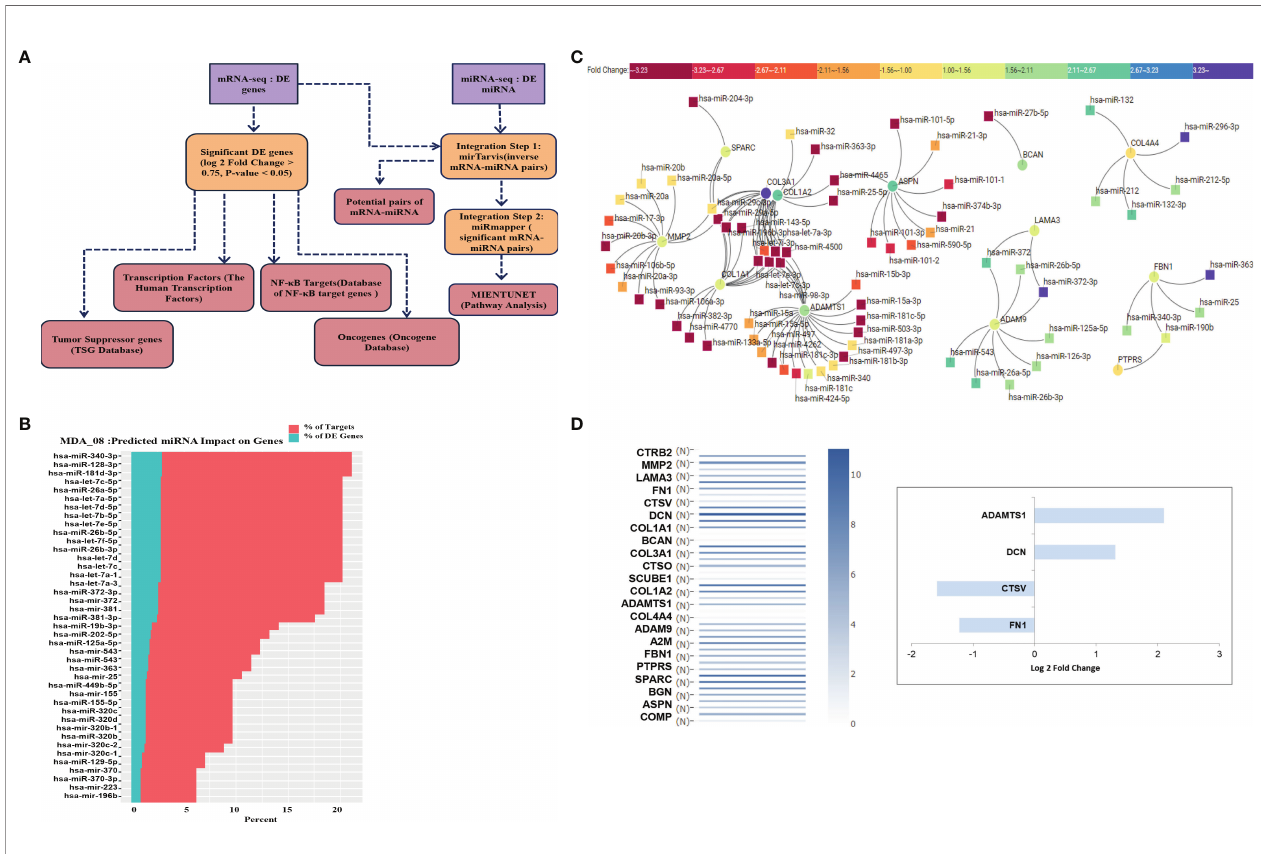
FIGURE 6 | Integrated analysis of miRNA-mRNA and Network analysis: (A) Flowchart showing the integration of miRNA-mRNA seq data. (B) DE expressed miRNA- mRNA data from MDA-MB-231 cells after ST08 treatment was integrated using miRmapper. (C) miRNA-mRNA network for ECM organization and degradation, regulated by ST08 in MDA-MB-231 cells. (D) Drug-induced changes were either upregulated/downregulated for expression in the tumour and reverted to normal expression post ST08